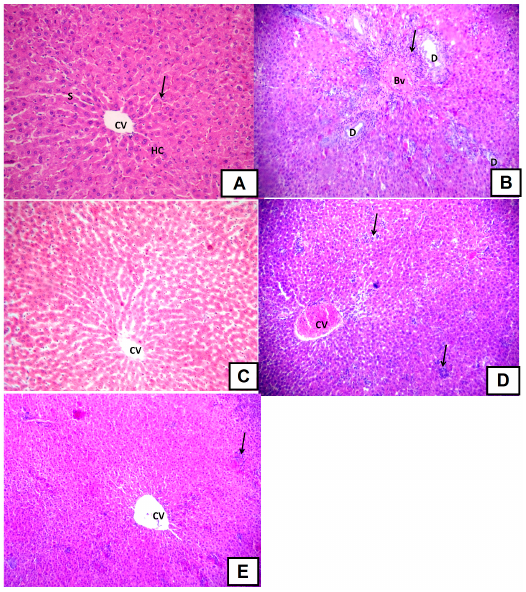
Figure 6. Photomicrographs of liver cross sections from 6 rats (200×). ( A ): A liver section of rat of the control group, revealing that liver tissue has normal histological structure with hepatic cords (HC) radiating from the central vein (CV) forming anastomosing plates separated by blood sinusoids (S). Hepatocytes are polyhedral with eosinophilic cytoplasm having central rounded and vesicular nuclei (arrow); ( B ): A liver section of one rat of D -GalN group, where the portal tract showed marked mononuclear cellular infiltration (arrow) and congested blood vessel (BV). Bile duct hyperplasia can be also seen (D); ( C ): Liver pre-treated with the bark extract (100 mg/kg) followed by D -GalN where the liver tissue appears nearly with normal histological structure; ( D ): Liver section of an adult rat pre-treated with Senna singeuana extract (200 mg/kg) followed by D -GalN group, where it showed similar pattern compared to D -GalN-treated group. There are multiple areas with mononuclear cellular infiltration (arrows) and congested central vein (CV); ( E ): Liver pre-treated with silymarin (100 mg/kg) followed by D -GalN showing partial improvement. There are some areas with mononuclear cellular infiltration